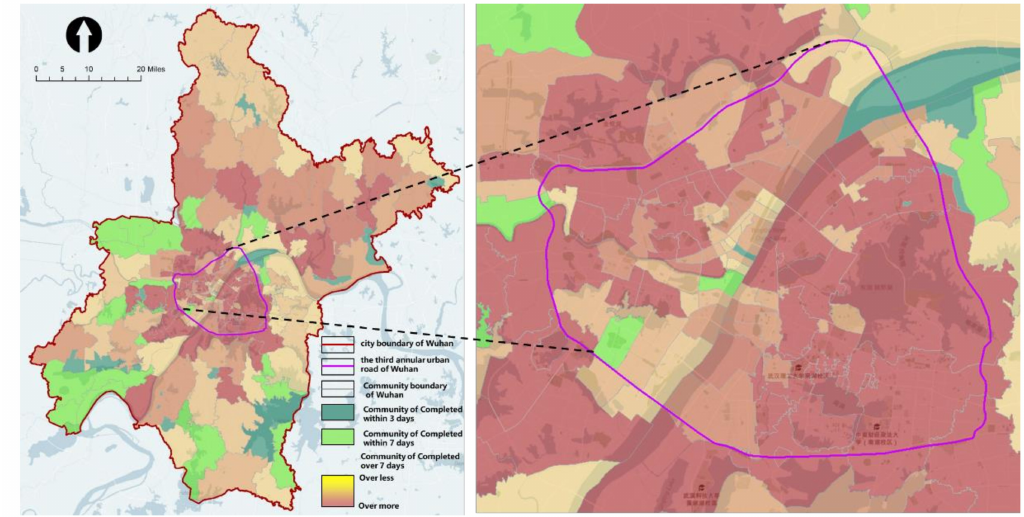
Figure 10. Time taken to complete community virus testing in Wuhan (in the early period of the COVID-19 pandemic). In terms of spatial distribution, the spatial clustering analysis using the “Optimized Hotspot Analysis” tool showed that most of the substandard communities (in dark red) were concentrated in and around the main urban area, especially on the south of the Yangtze